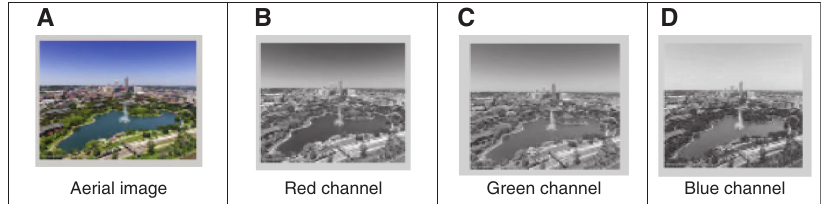
Figure 2: (A–D) Original “Aerial” Image with R, G, and B